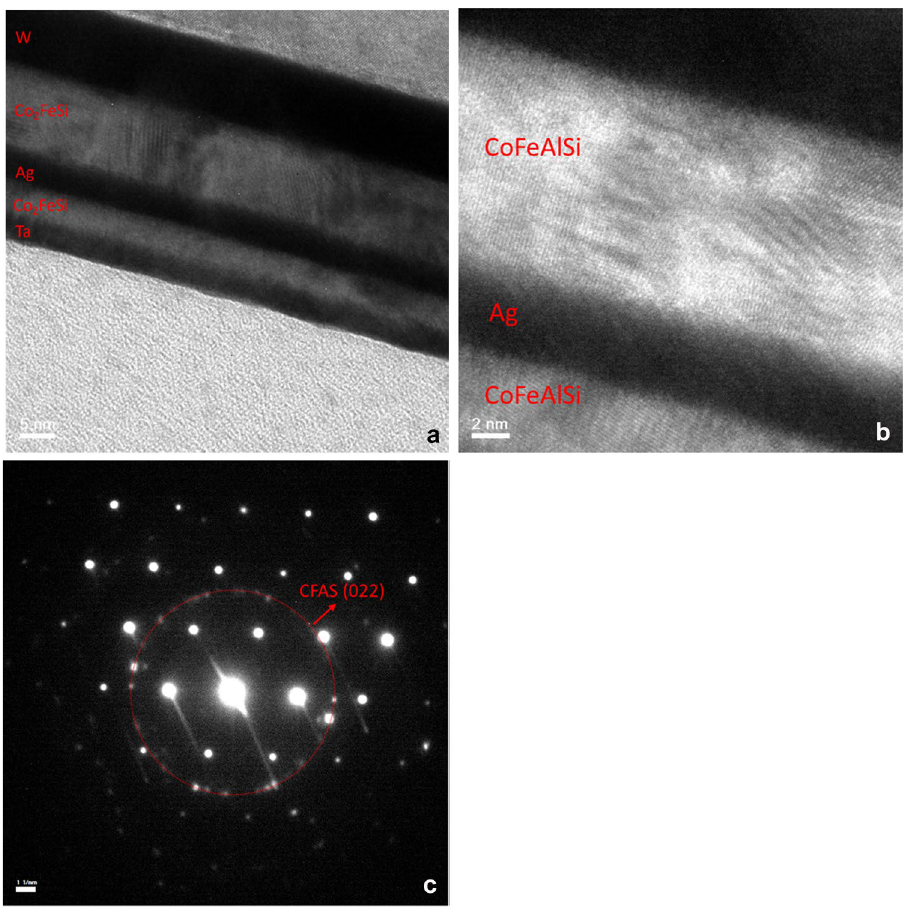
Figure 3. Structural analysis of crystallised GMR device by current introduction. Cross-sectional TEM images of the GMR device after the current-induced crystallisation is completed as similar to N > 15,000 in Fig. 2 with ( a ) 300 k and ( b ) 800 k magnification. ( c ) Diffraction pattern obtained using